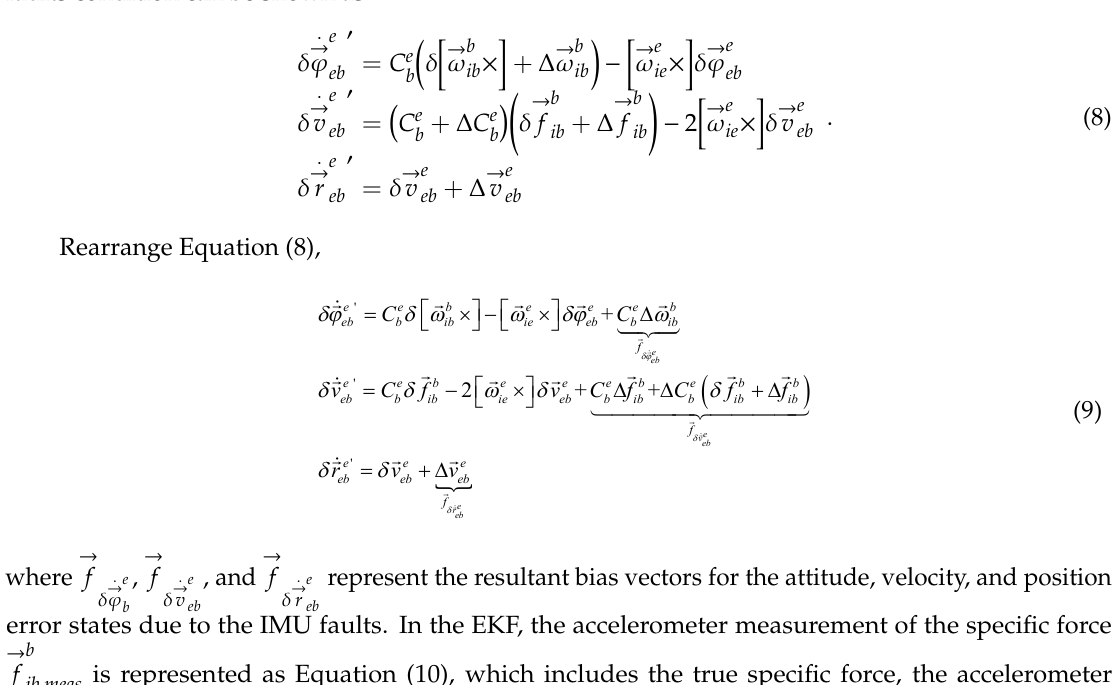
Figure 2. Navigation parameters update process for the IMU.